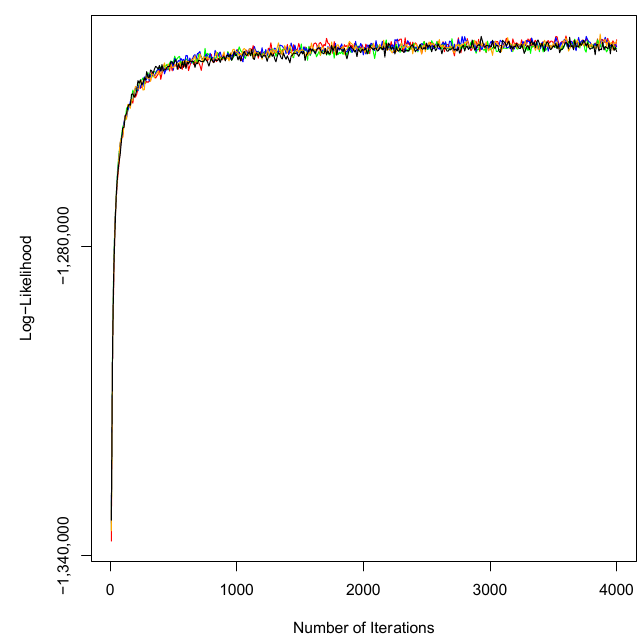
Figure 3. Convergence of the log-likelihood for five sets of 4000 iterations.